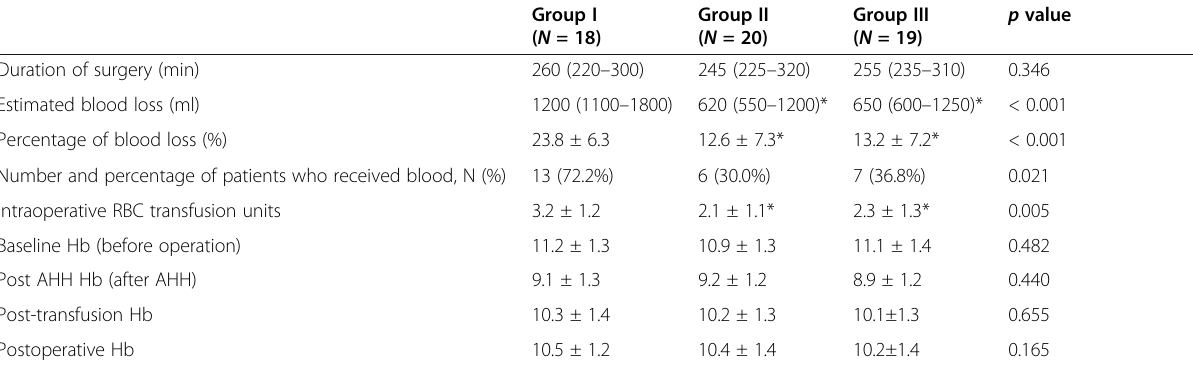
Table 2 Surgery and transfusion variables of patients in the three study groups